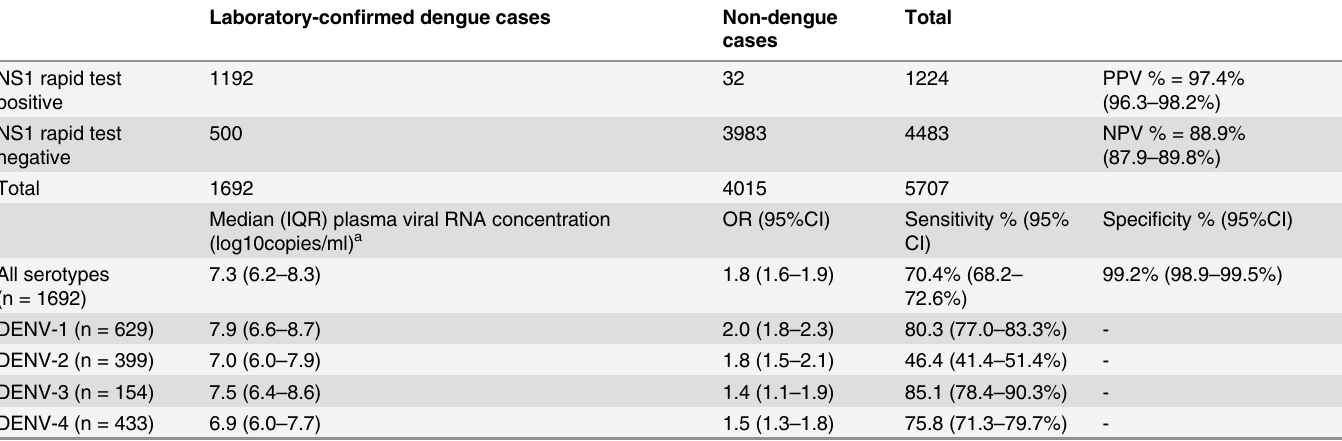
Table 2. Diagnostic performance of NS1 rapid test in enrolment plasma samples and odds of NS1 detection in relation to plasma viremia. Laboratory-con fi rmed dengue